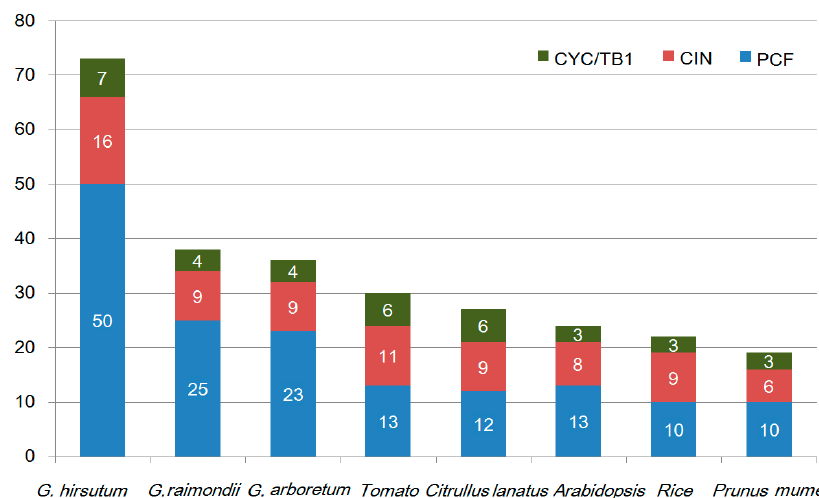
Figure 1. Phylogenetic analysis of TCP proteins from G. hirsutum , Arabidopsis , and rice. The deduced full-length amino acid sequences were aligned using ClustalX 2.0 and the phylogenetic tree was constructed using MEGA 6.0 by the Neighbor-Joining (NJ) method with 1000 bootstrap replicates. The three subclasses are indicated with different colors.